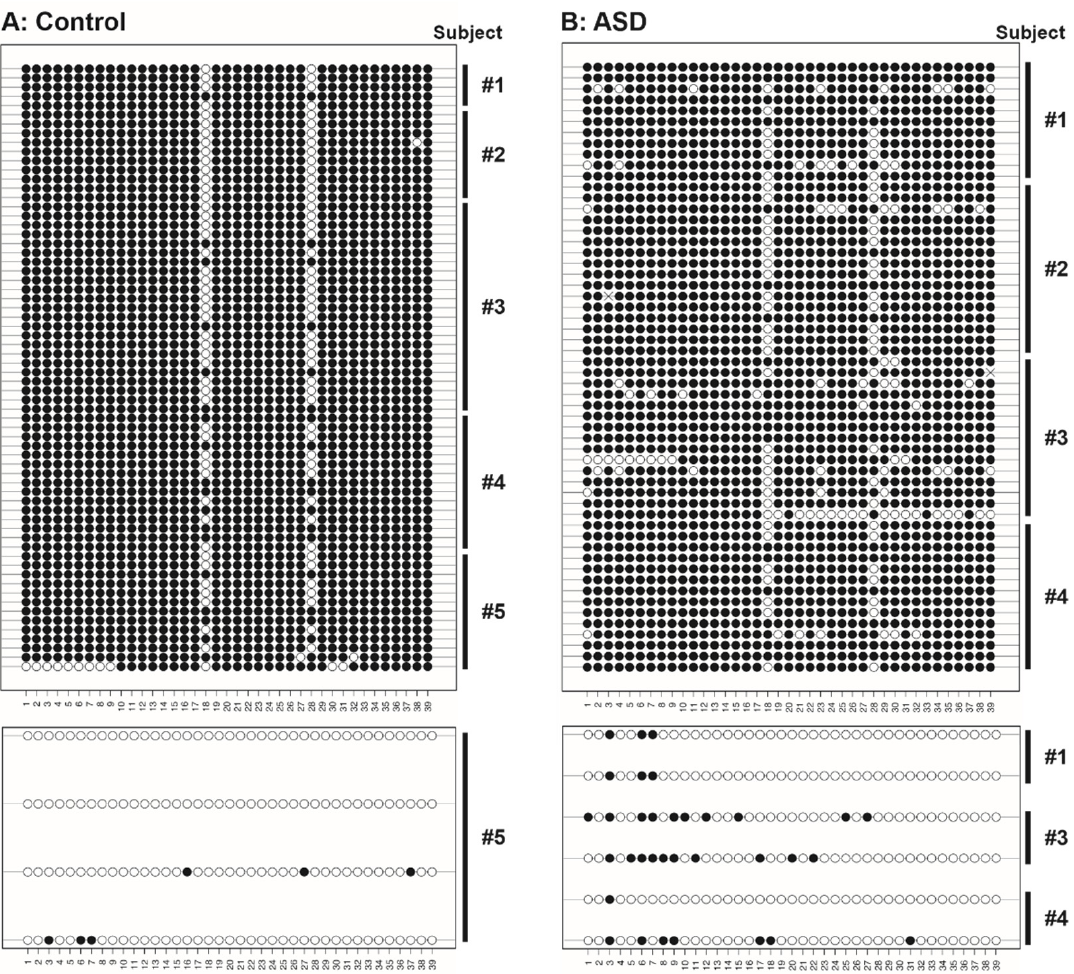
Figure 2. Lollipop plot of methylation patterns of individual CpG sites across the GAD1 target region of interest in cerebral organoids derived from ( A ) control (N = 70 clones from 5 subjects) and ( B ) ASD subjects (N = 62 clones from 4 subjects). Rows represent the GAD1 amplicons from randomly picked individual clones, symbols represent individual CpG sites within the amplicon. Filled dots, methylated cytosines; empty dots, unmethylated cytosines; × , cytosine-to-adenine mutation. Clones with <50% methylation are shown separately on the lower panels.